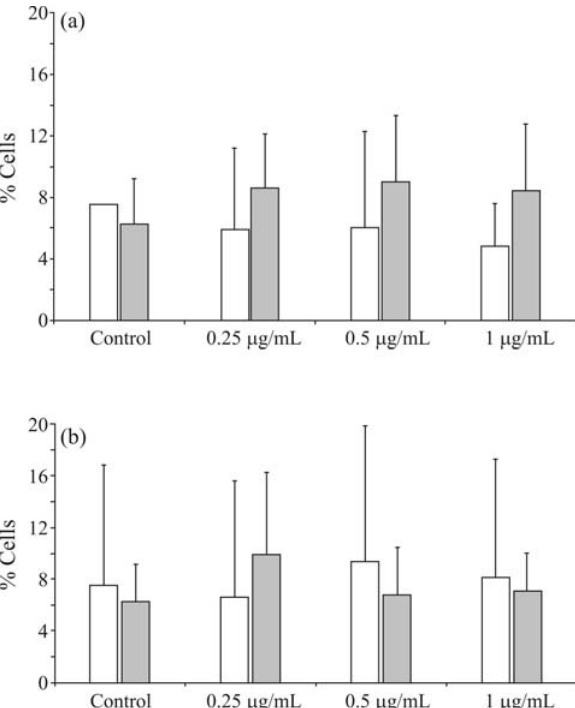
Figure 2 - MLL (A) and IGH (B) mean translocation and extra signal fre- quencies observed in peripheral blood lymphocytes cultures treated with different etoposide concentrations. P: one-hour-pulse treatment. *statisti- cally different. p < 0.05.